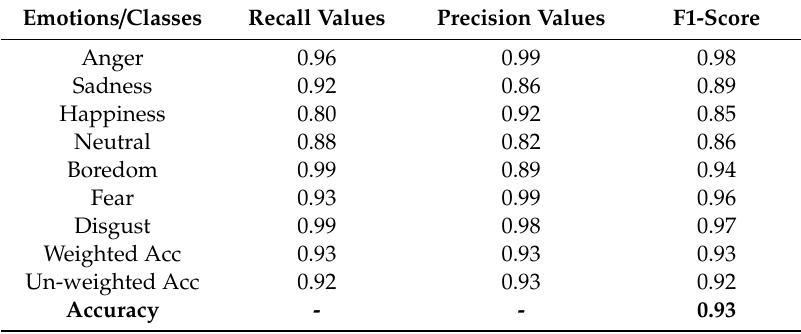
Table 6. Prediction performance of the suggested SER system for the EMO-DB dataset using speech spectrograms.